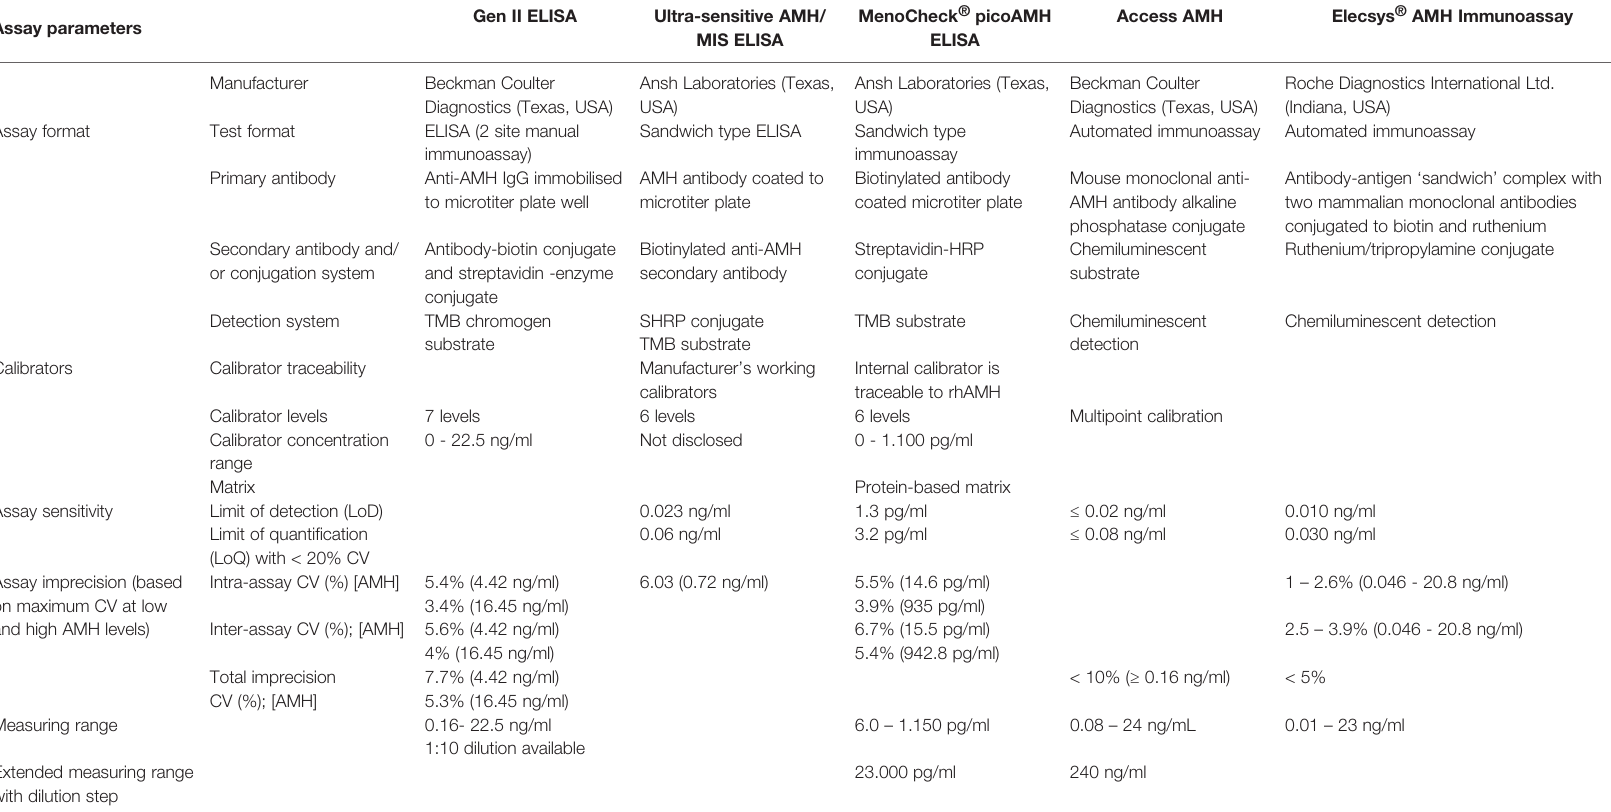
TABLE 1 | Analytical characteristics of immunoassays currently used to measure AMH (9 – 13). Assay